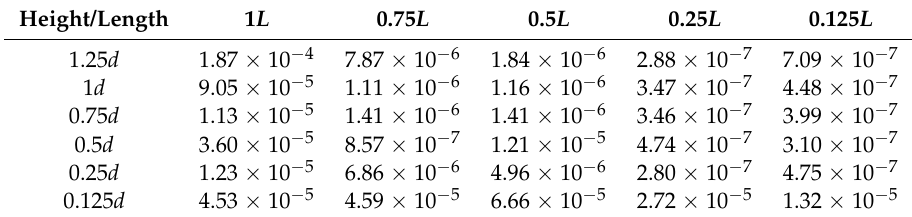
Table A1. MSE values for different source heights and lengths, deep water